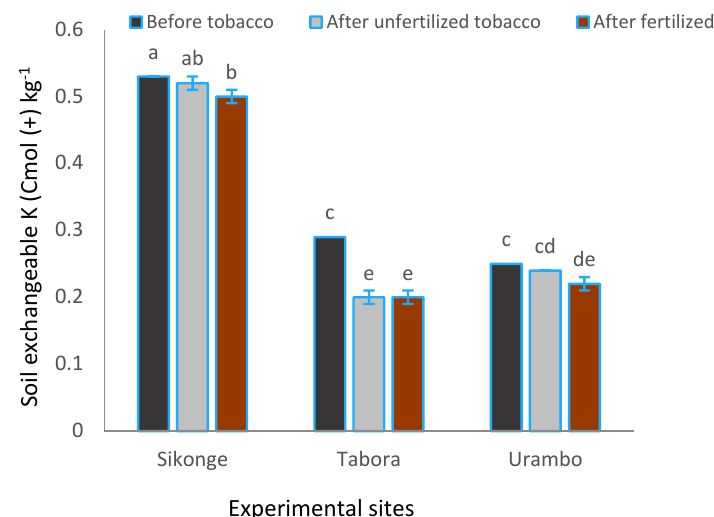
Figure 6. Effect of tobacco and fertilization on soil K. ‘a’ & ‘ab’ are very highly significant; ‘b’ is highly significant; ‘c’, & ‘cd’ are significant; ‘de’ & ‘e’ non significant. Soil exchangeable Ca differed significantly ( p < 0.001) across the sites where the highest (1.56 cmol (+) kg − 1 ) was recorded in Sikonge (Table 2). Inclusion of tobacco significantly ( p < 0.001)